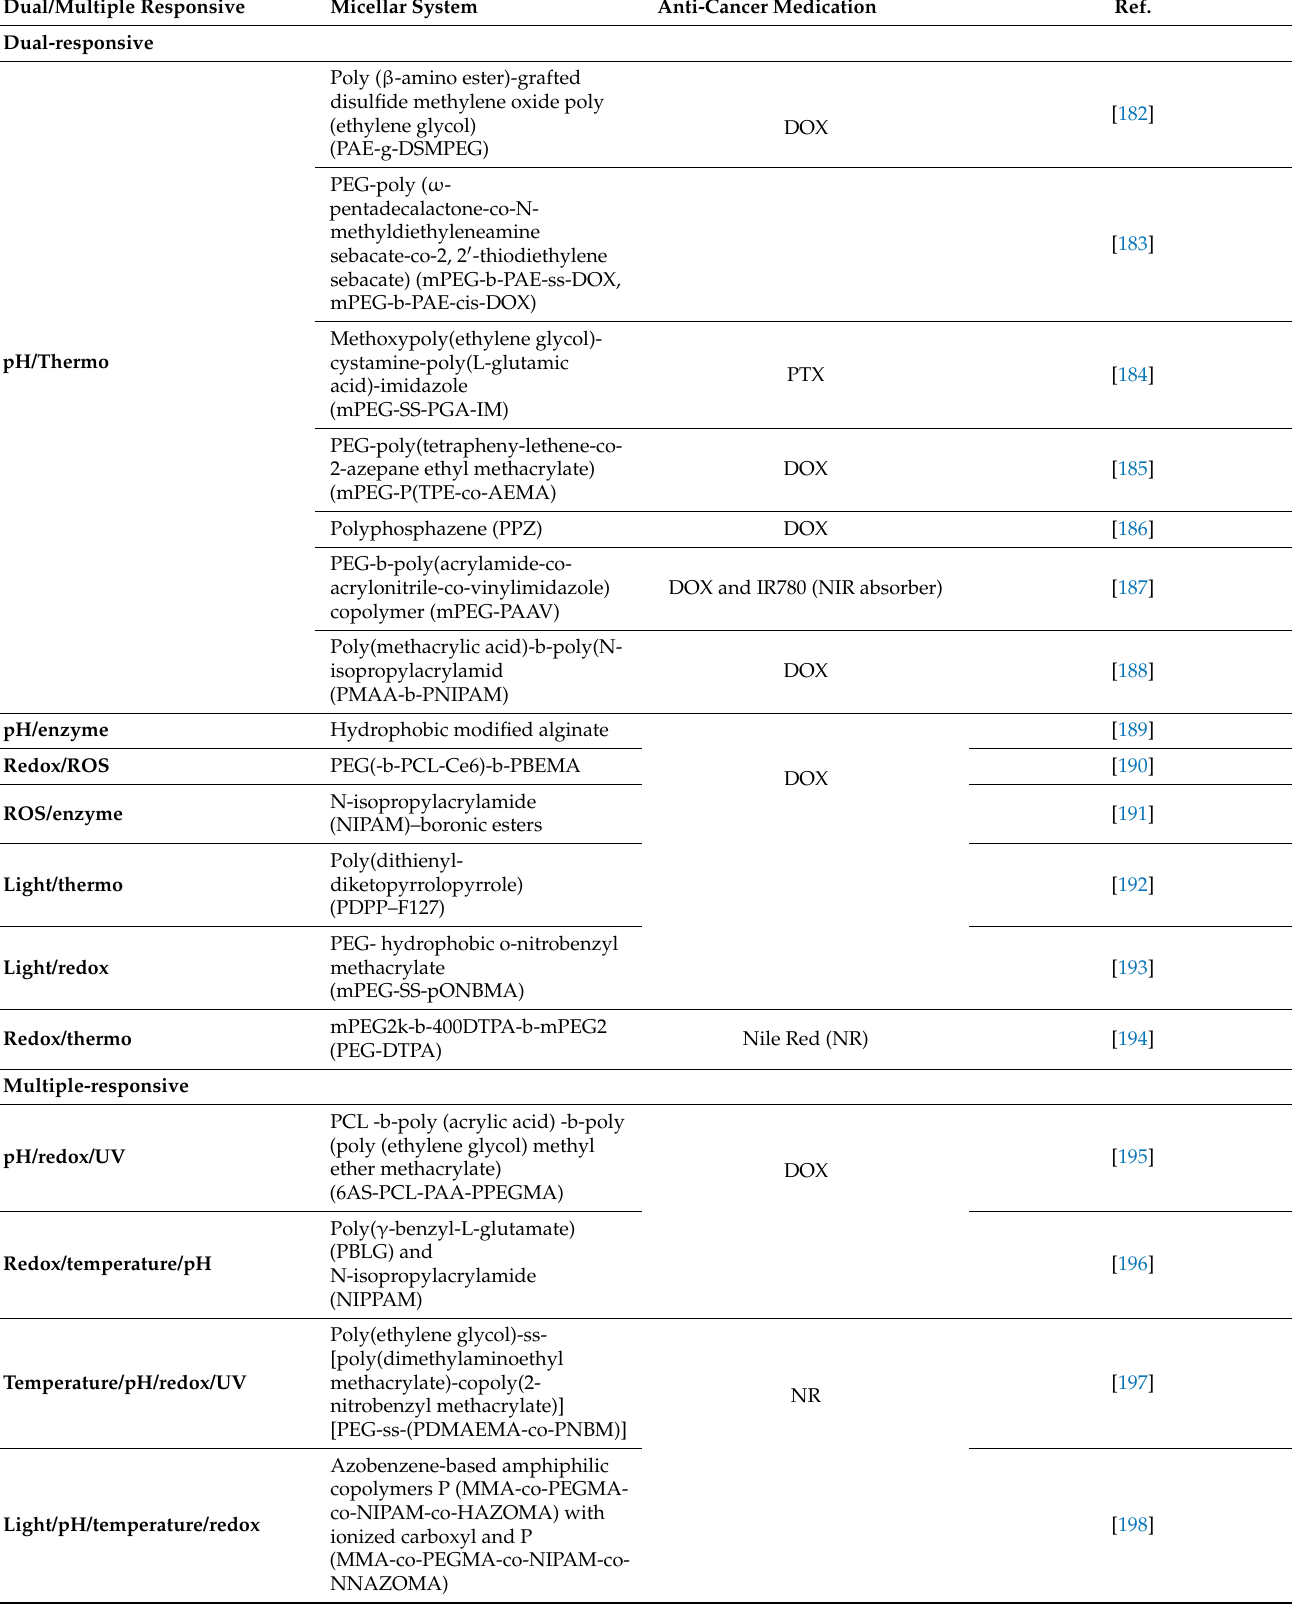
Table 4. Examples of dual/multiple responsive micellar